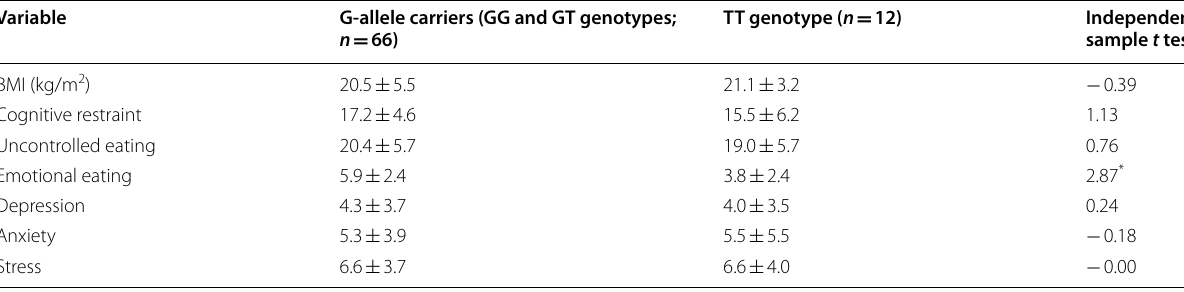
Statistics: data are reported as numbers (mean